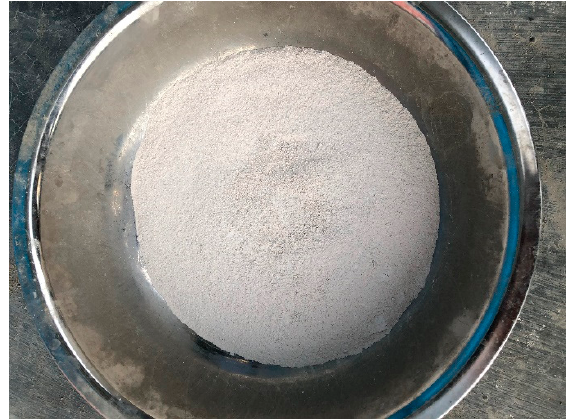
Figure 2. Photograph of MgO. Table 3. Chemical composition of MgO.